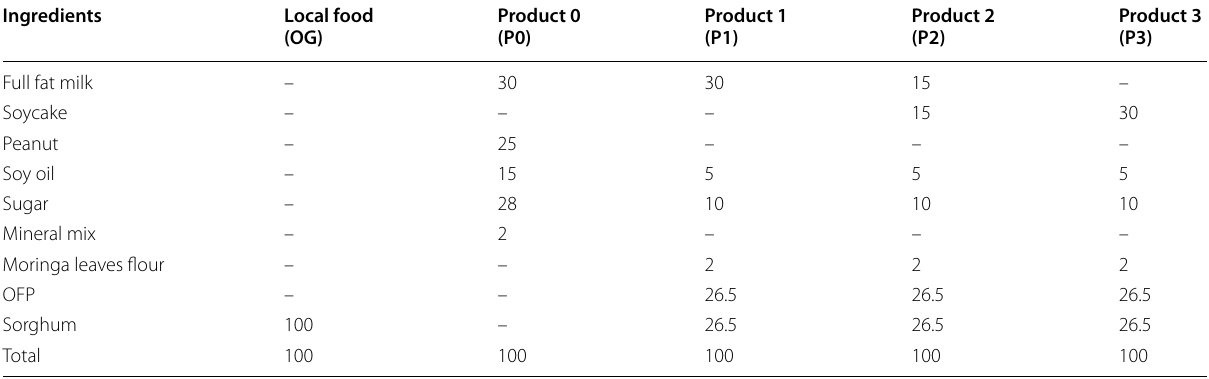
Table 1 Formulation of therapeutic complementary